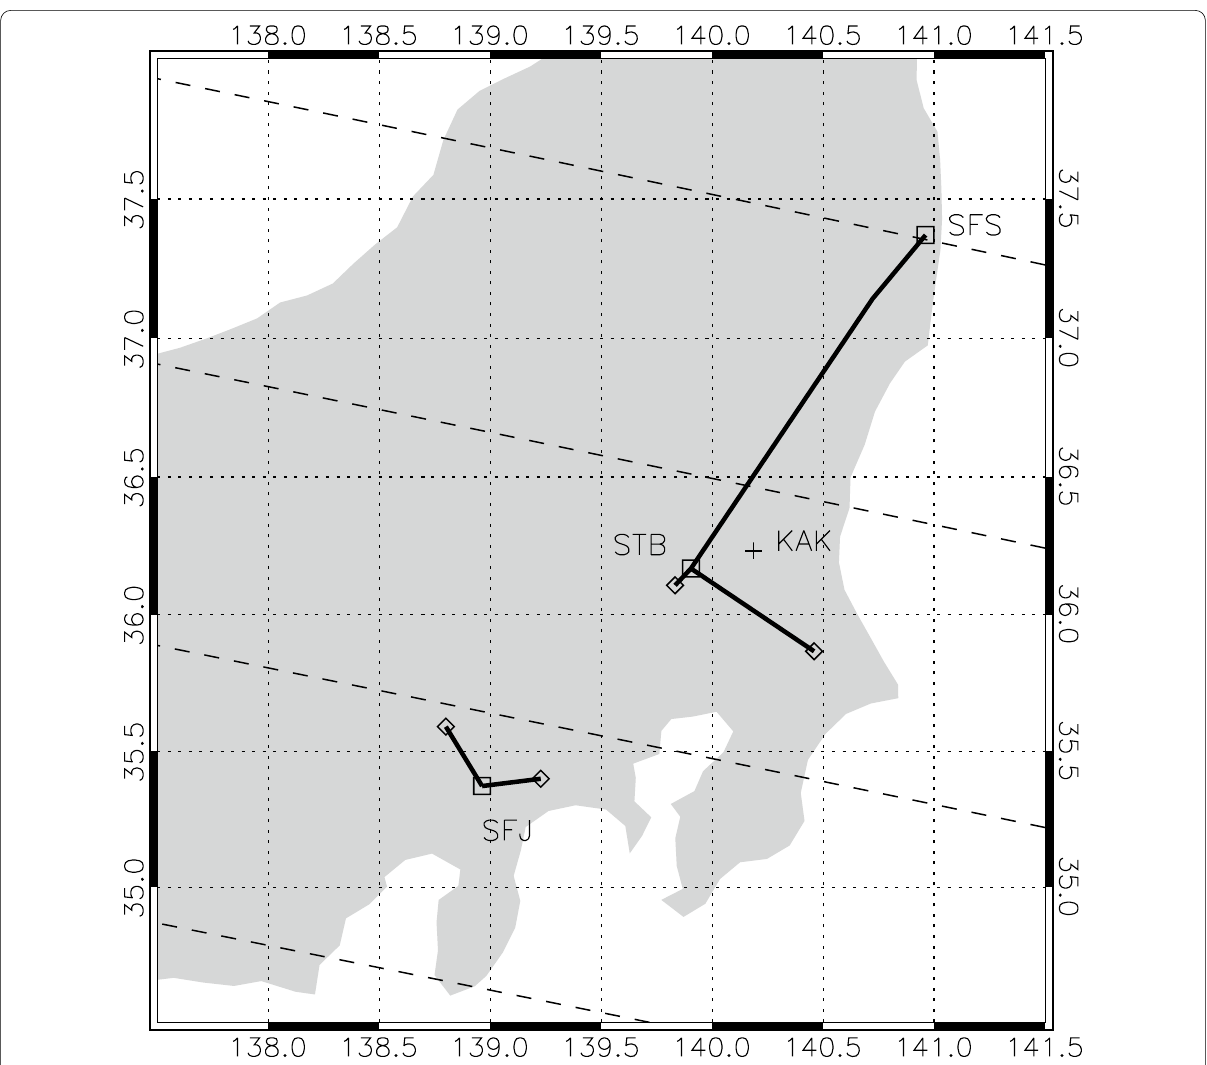
Fig. 3 Locations of GIC measurements of 500 kV lines. Squares show substations, where GIC measurements are performed, and diamonds show their neighbor substations. Solid lines show 500 kV lines between substations. The plus sign shows the location of the Kakioka Magnetic Observatory (KAK). The dashed lines show geomagnetic latitudes of 30º, 31º, 32º, and 33º,